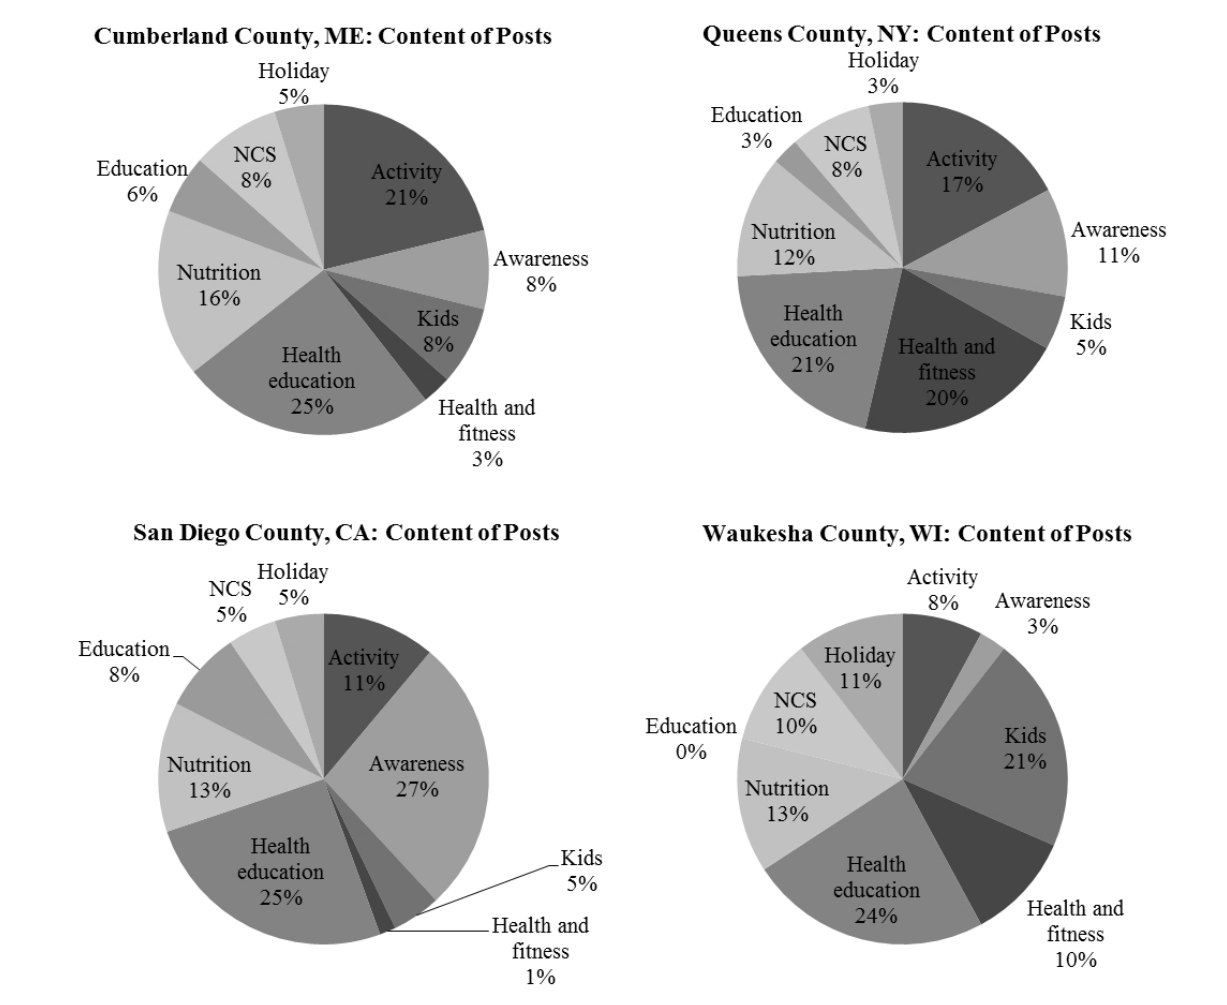
Figure 3. Content posted by each Study Center over the pilot